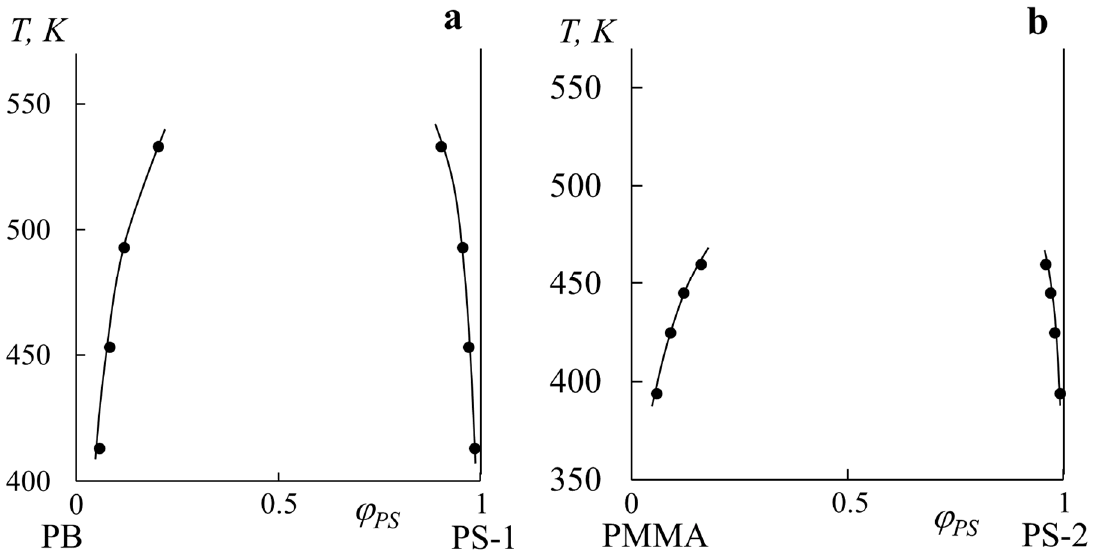
Figure 4. Fragments of binodal curves for PB–PS-1 ( a ) and PMMA–PS-2 ( b ) systems obtained by optical interferometry.